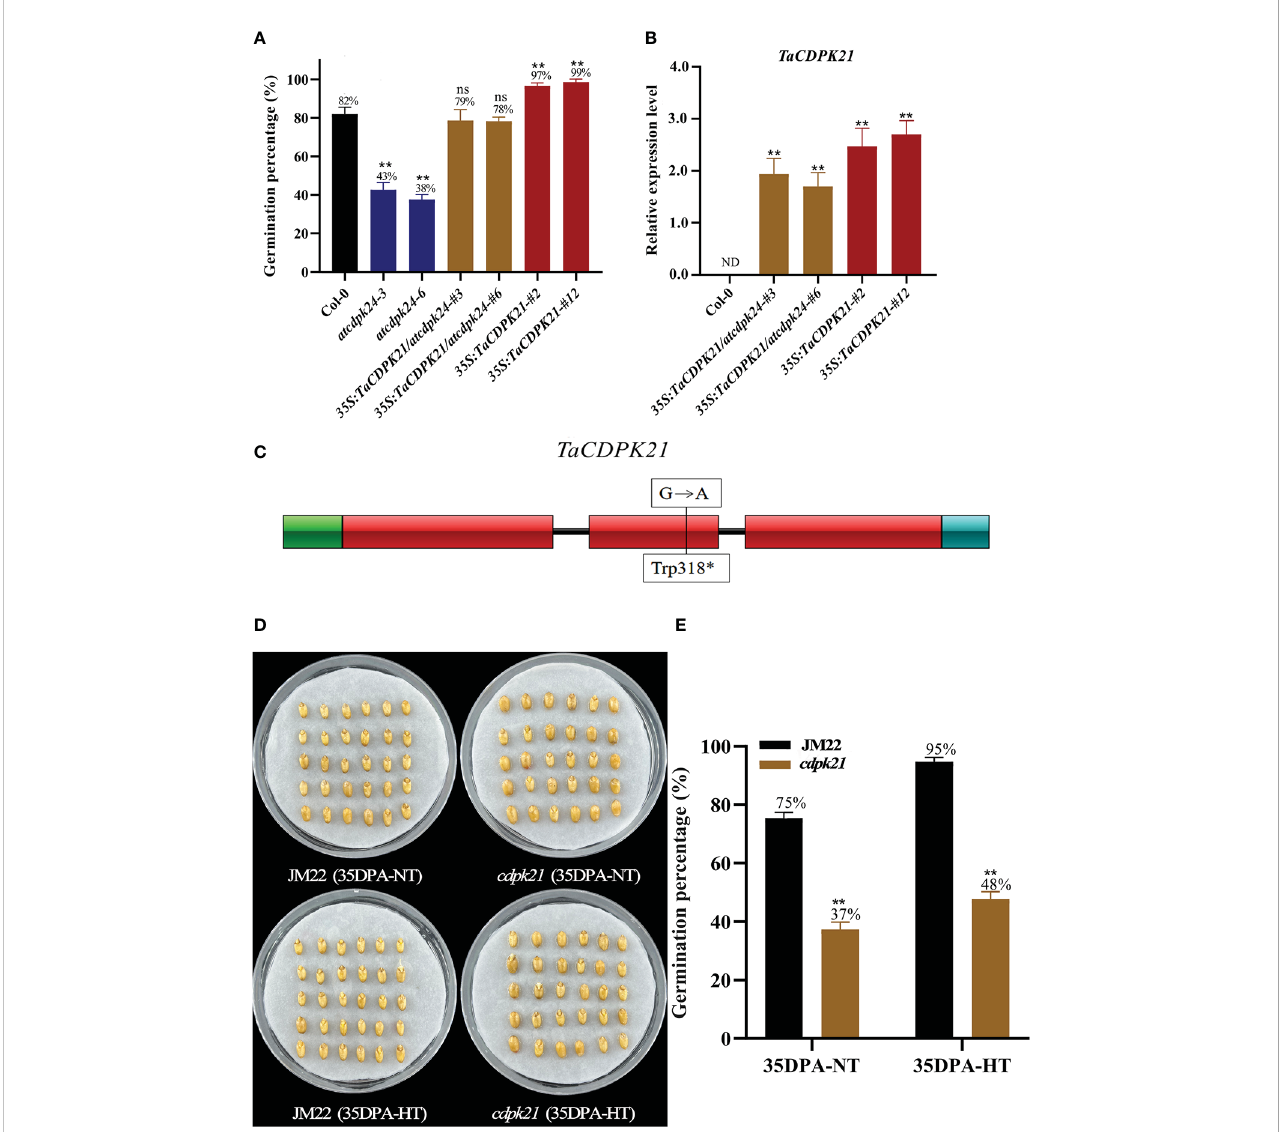
FIGURE 3 TaCDPK21 signi fi cantly and negatively regulates seed dormancy. (A) Germination percentages of Col-0, the T-DNA mutant atcdpk24 , overexpression plants ( 35S:TaCDPK21 ), and complementation of TaCDPK21 ( 35S:TaCDPK21/atcdpk24 ) in Arabidopsis . Data are the mean ± standard error (SE), n = 10 – 15. Signi fi cant differences were determined using Student ’ s t-test: ** P < 0.01. ns represents not signi fi cant (B) Relative expression of TaCDPK21 in Col-0, overexpression Arabidopsis plants ( 35S:TaCDPK21 ), and complementation of TaCDPK21 ( 35S:TaCDPK21/atcdpk24 ). RNA was extracted from seeds imbibed for 24 h. ND represents not detected. (C) Mutation site of cdpk21 . * represents terminator (D) The seed images of Jimai 22 (JM22) and the EMS mutant ( cdpk21 ) after 96-h imbibition conducted at normal temperature (25°C/20°C). (E) Germination percentages of JM22 and the EMS mutant ( cdpk21 ) on the 7th day of germination tests conducted at normal temperature (25°C/20°C) and high-temperature (35°C/25°C) environments. Signi fi cant differences were determined using Student ’ s t-test: ** P < 0.01. Data are the mean ± standard error (SE), n = 10 –